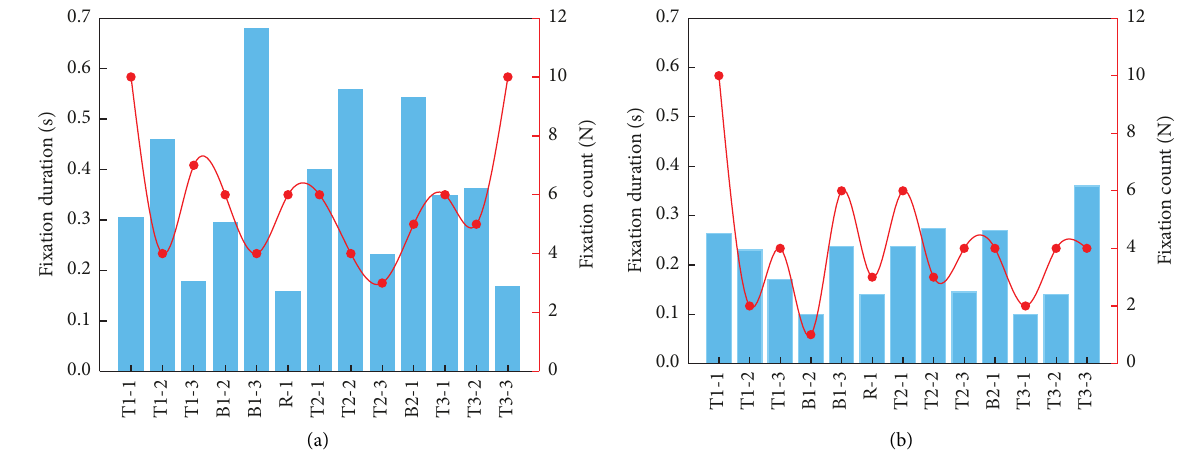
Figure 8: Fixation behavior. (a) Day. (b) Night.